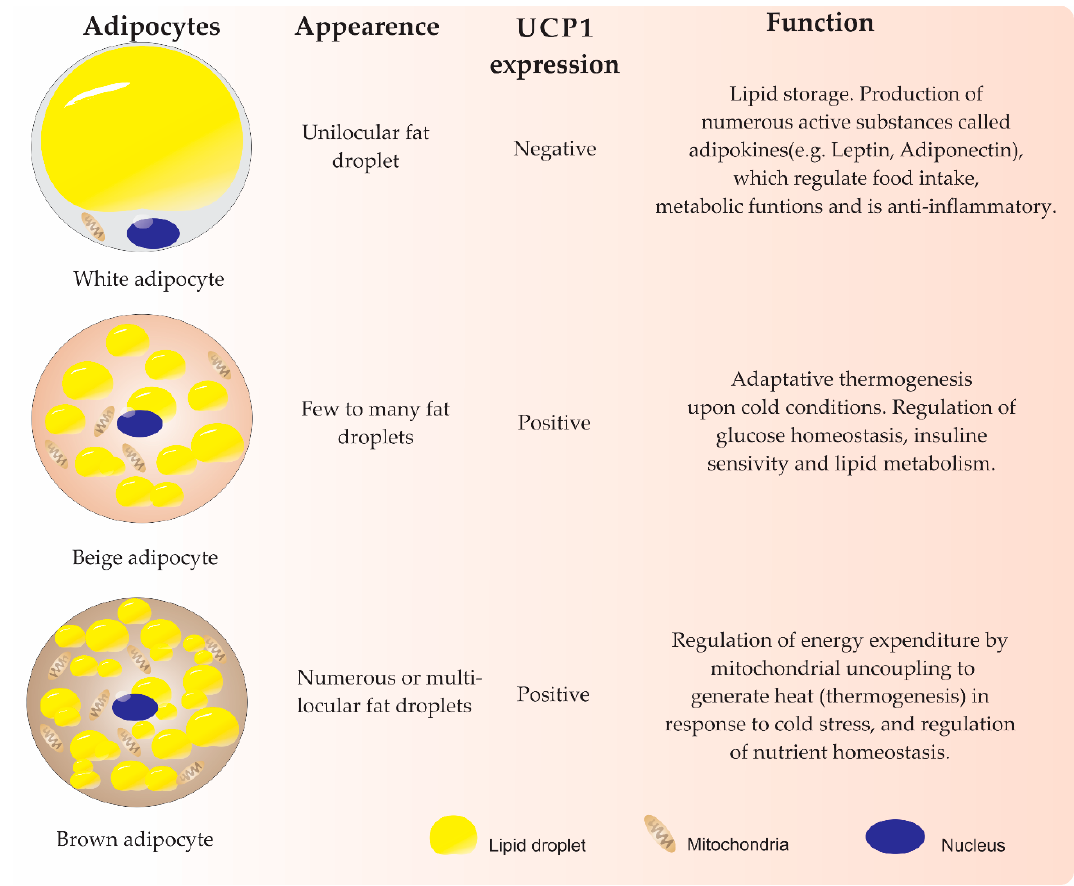
Figure 1. Properties of adipose tissue [2,4,5,10 − 13,15,22,23].